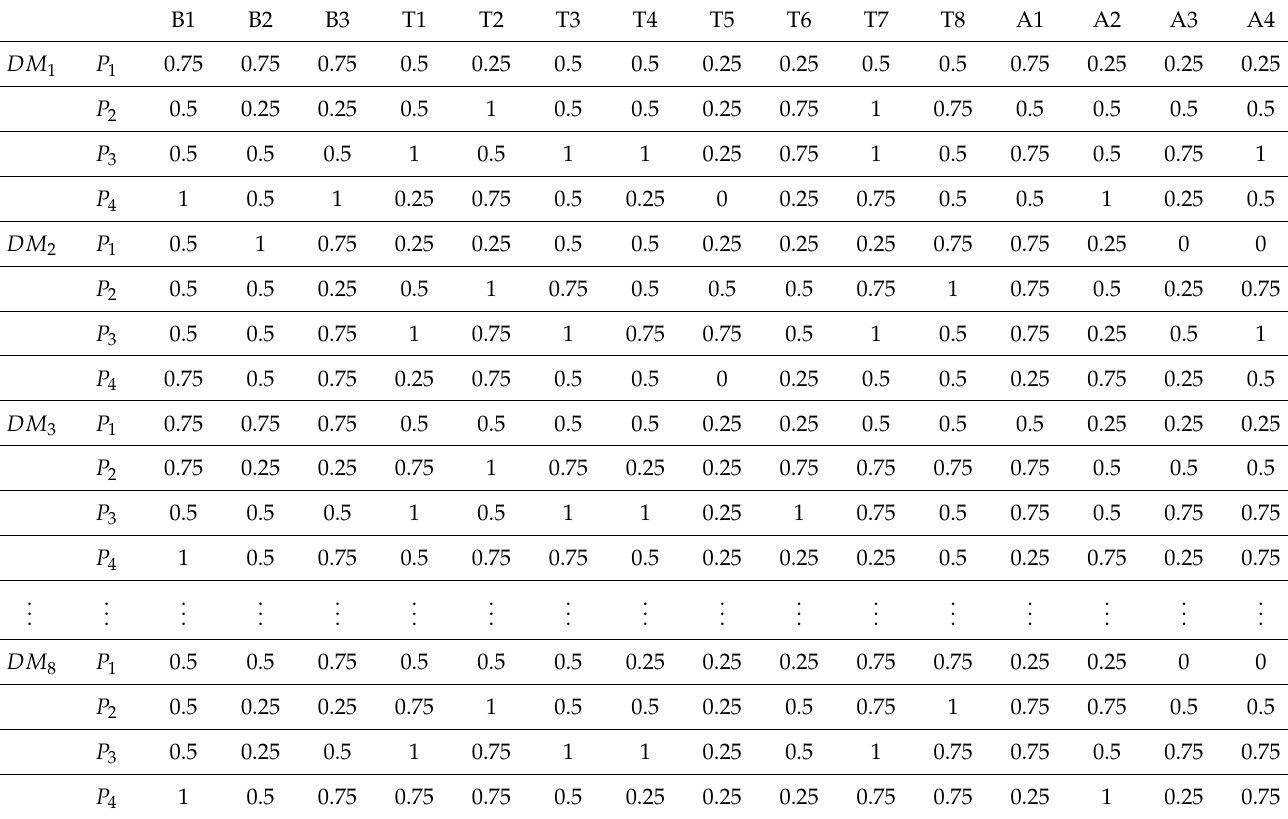
Table A3. The group fuzzy initial direct decision